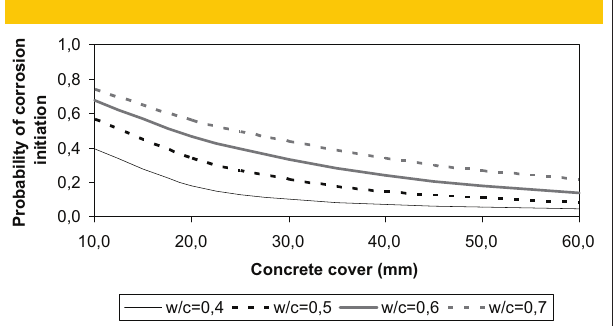
Figure 9 – Evolution for probability of corrosion initiation – C.A.II structural life-time = 25